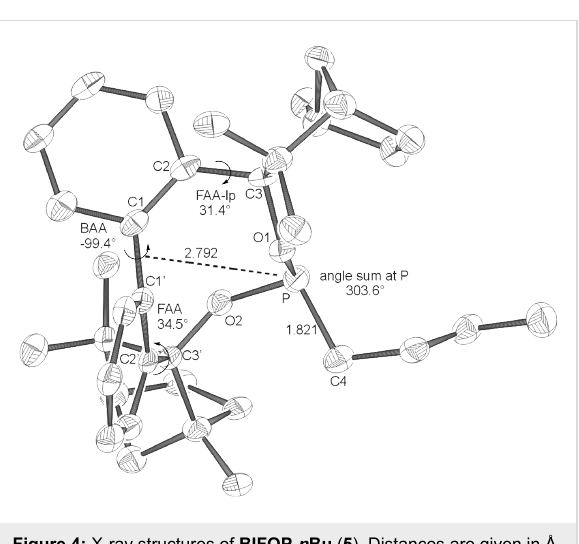
Figure 6: X-ray structures of phosphite BIFOP-OPh ( 6 ). Distances are given in Å. (BAA = biaryl angle between C 2 -C 1 -C 1 '-C 2 '; FAA-lp = fenchyl-aryl dihedral angle between C 1 -C 2 -C 3 -O 1 ; FAA = fenchyl-aryl dihedral angle between C 1 '-C 2 '-C 3 '-O 2 ). The probability of ellipsoids is 40% (CCDC 270535).